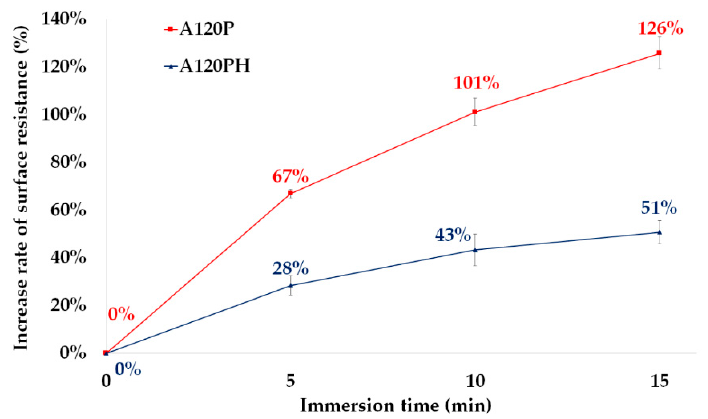
Figure 10. Surface resistivity of a sample treated with an NaOH solution and followed by PPy polymerization (A120P) and a sample treated with an NaOH solution and followed by PPy polymerization and hydrophobic coating (A120PH) by the duration of the immersion at water.